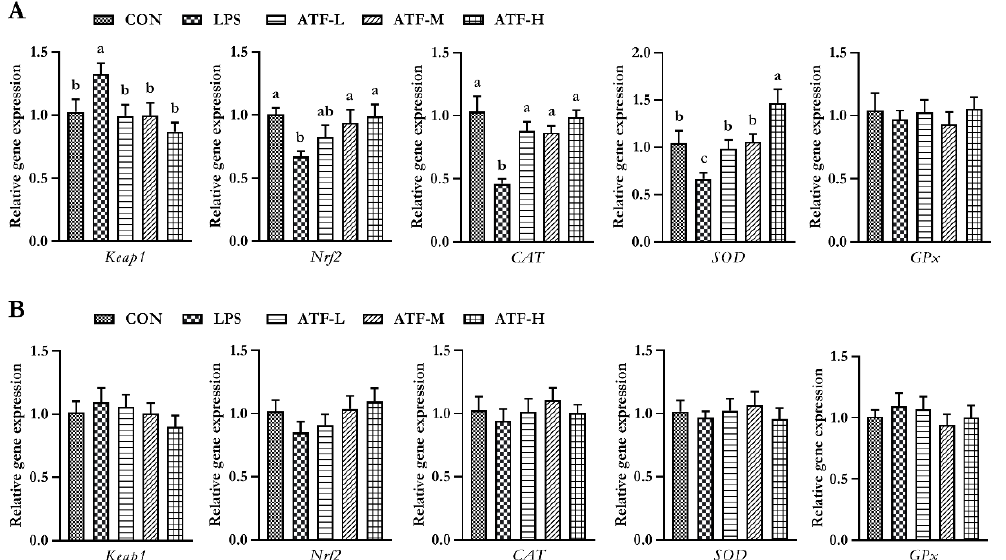
Figure 1. Effect of ATF on the expression of antioxidant-related genes in the liver of broilers challenged with LPS. ( A ) The data of antioxidant-related gene expression in the liver of broilers at 28 days. ( B ) The data of antioxidant-related gene expression in the liver of broilers at 42 days. Abbreviations: Keap1, Kelch-like ECH-associated protein-1; Nrf2, nuclear factor-erythroid 2-related factor 2; CAT, catalase; SOD, total superoxide dismutase; GPx, glutathione peroxidase; ATF, Artemisia ordosica alcohol extract; CON, non-challenged broilers fed a basal diet; LPS, lipopolysaccharide-challenged broilers fed a basal diet; ATF-L, lipopolysaccharide-challenged broilers fed a basal diet supplemented with 500 mg/kg ATF; ATF-M, lipopolysaccharide-challenged broilers fed a basal diet supplemented with 750 mg/kg ATF; ATF-H, lipopolysaccharide-challenged broilers fed a basal diet supplemented with 1000 mg/kg ATF. Each value is shown as the mean and standard error of mean (SEM) ( n = 6); Bars with different letters (a, b, and c) are significantly different ( p < 0.05), while bars with the same letter indicate no significant difference between groups ( p ≥ 0.05).